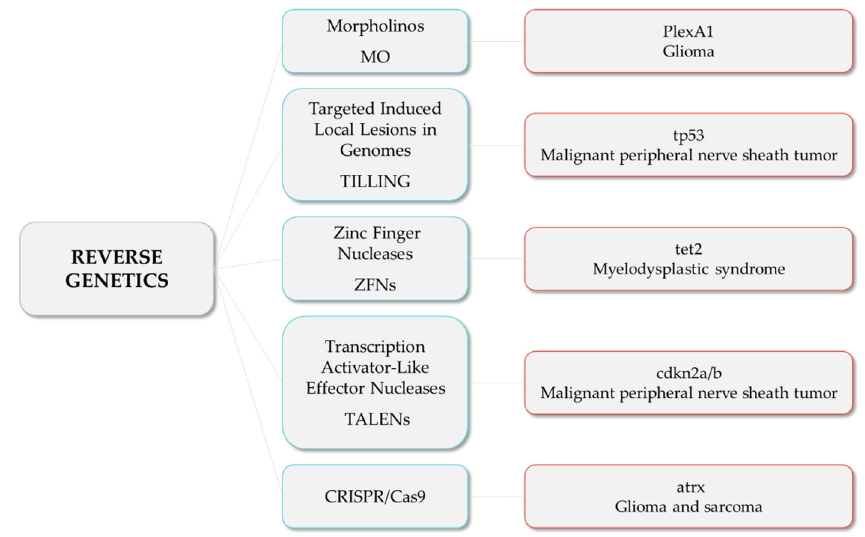
Figure 2. Reverse genetics strategies (in blue) and their respective examples of altered genes and the associated tumor types.